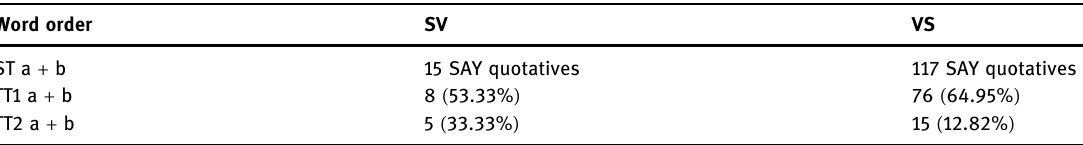
Table 6: SAY quotatives in translation